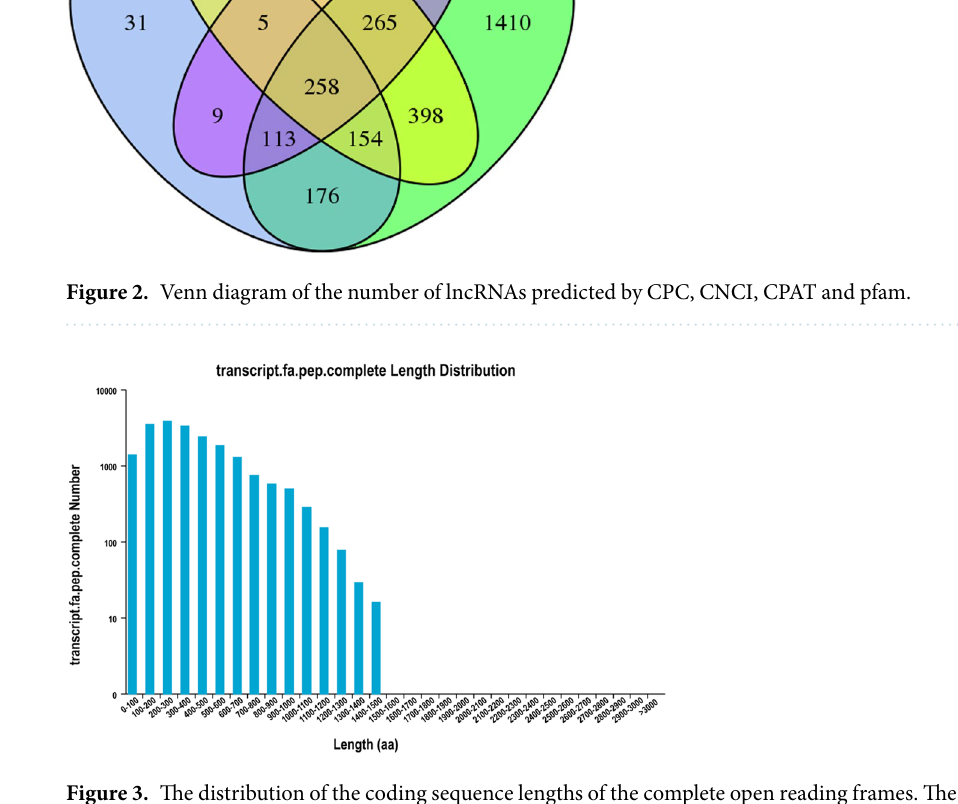
Annotated databases